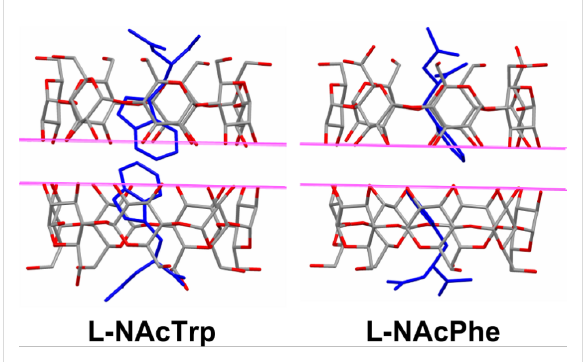
Figure 5: L-NAcTrp and L-NAcPhe in β -CD dimers (the lines indicate the levels of the O2 and O3 secondary hydroxy